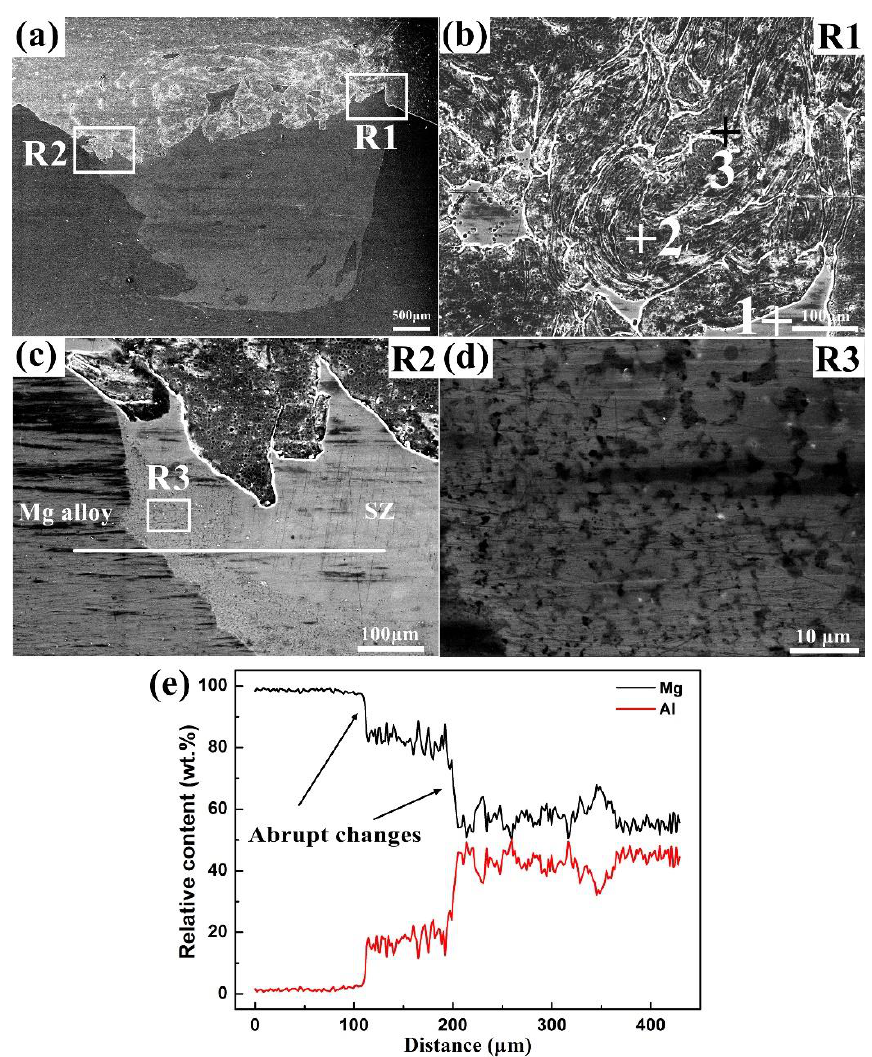
Figure 4. Representative microstructures of the Al/Mg joint: ( a ) overview of the SZ, ( b – d ) magnified views of the R1, R2, and R3, respectively, and ( e ) EDS line-scan results of the R2. Table 2. Elemental compositions (in wt.%) at points 1–3 in Figure 4b.